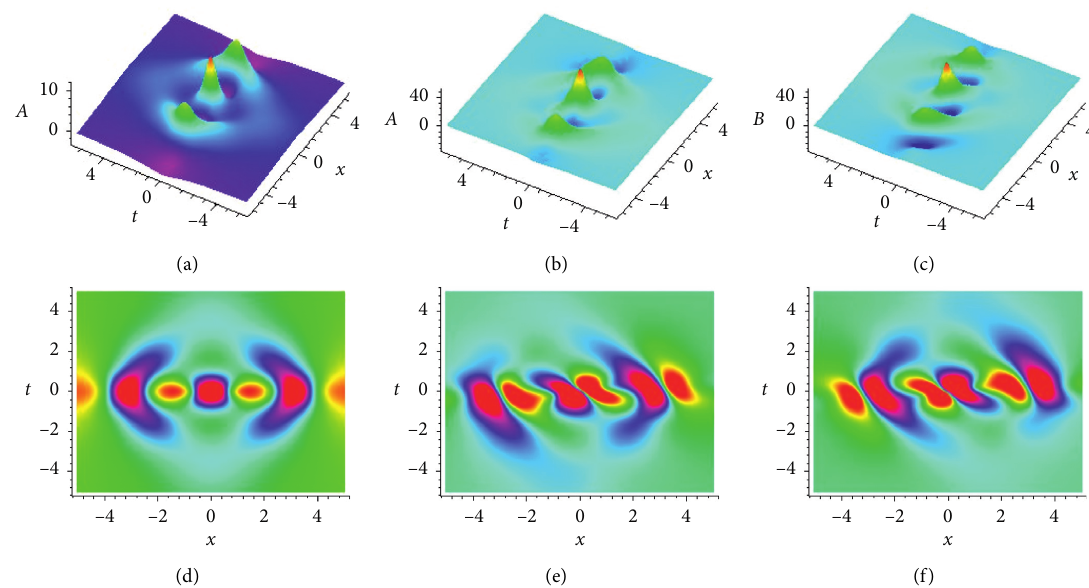
Figure 11: The third-order symmetry-breaking lump solution under the invariant condition F ( x,t ) � F (− x + x systems (7a) and (7b) with (a) b